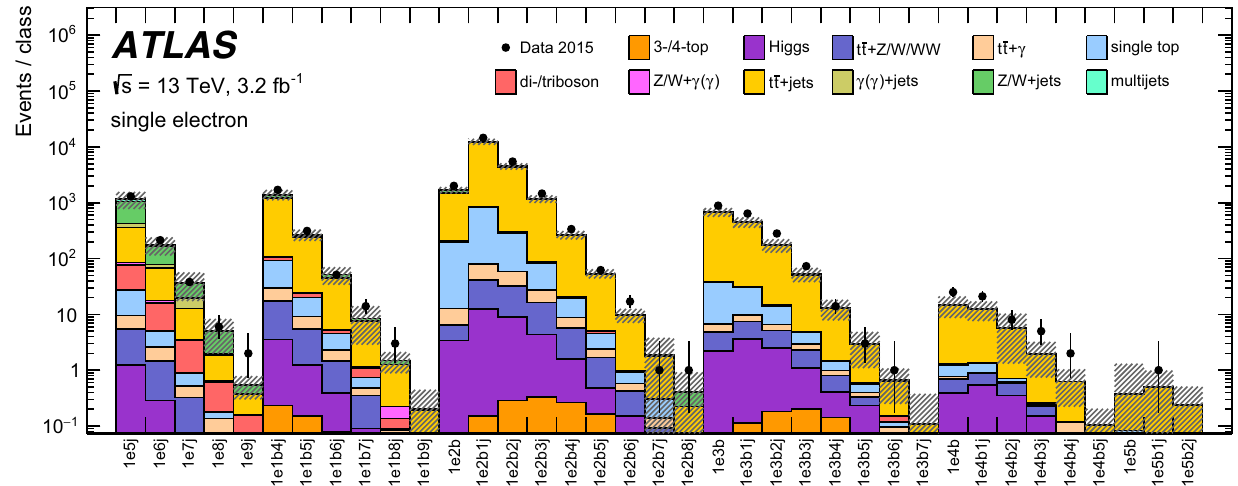
Fig. 12 The number of events in data, and for the different SM back- groundpredictionsconsidered,forclasseswithoneelectronand( b -)jets (no muons, photons or E miss ). The classes are labelled according to the T